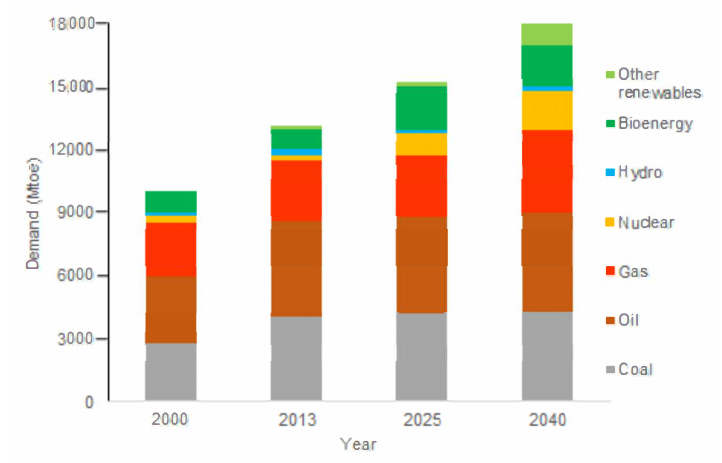
Figure 1. Projected world energy